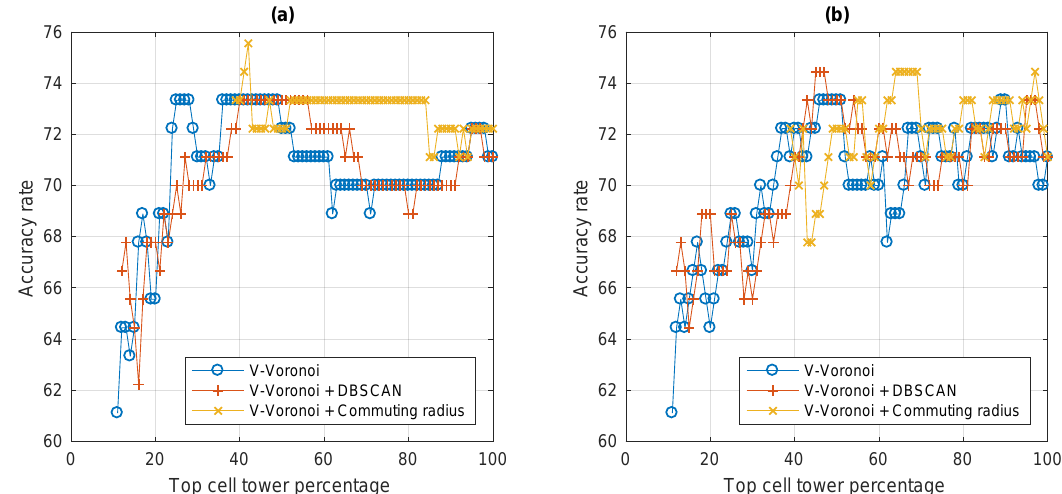
Figure22. ResultsofthevisitedVoronoicell-basedmethodswithandwithoutnoisefiltering; ( a )summed distance approach and ( b ) shortest distance